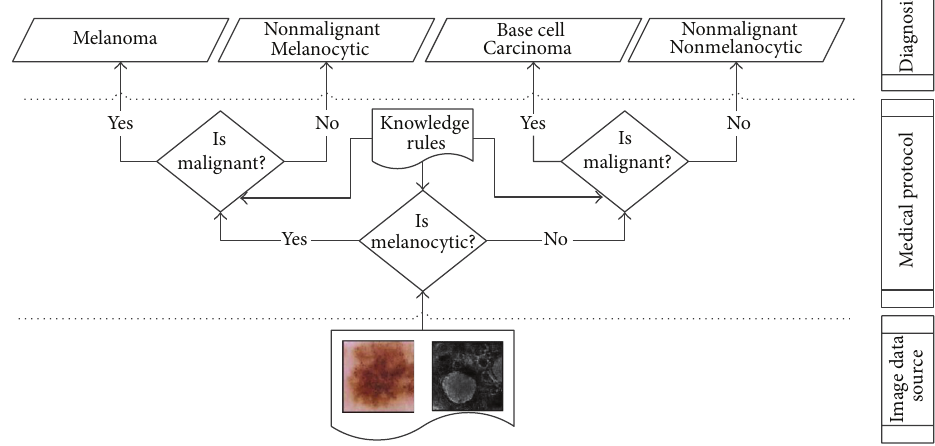
Figure 3: Medical diagnosis protocol schema followed by dermatological cancer